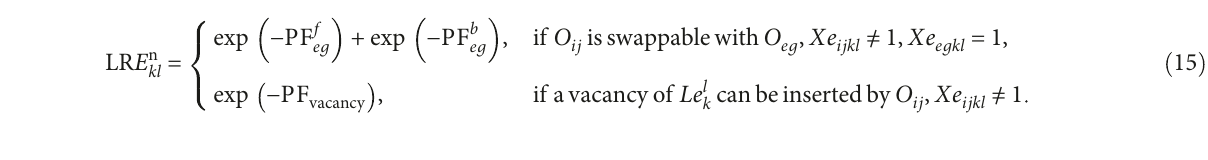
Figure 5. If there are no predecessors of operation O